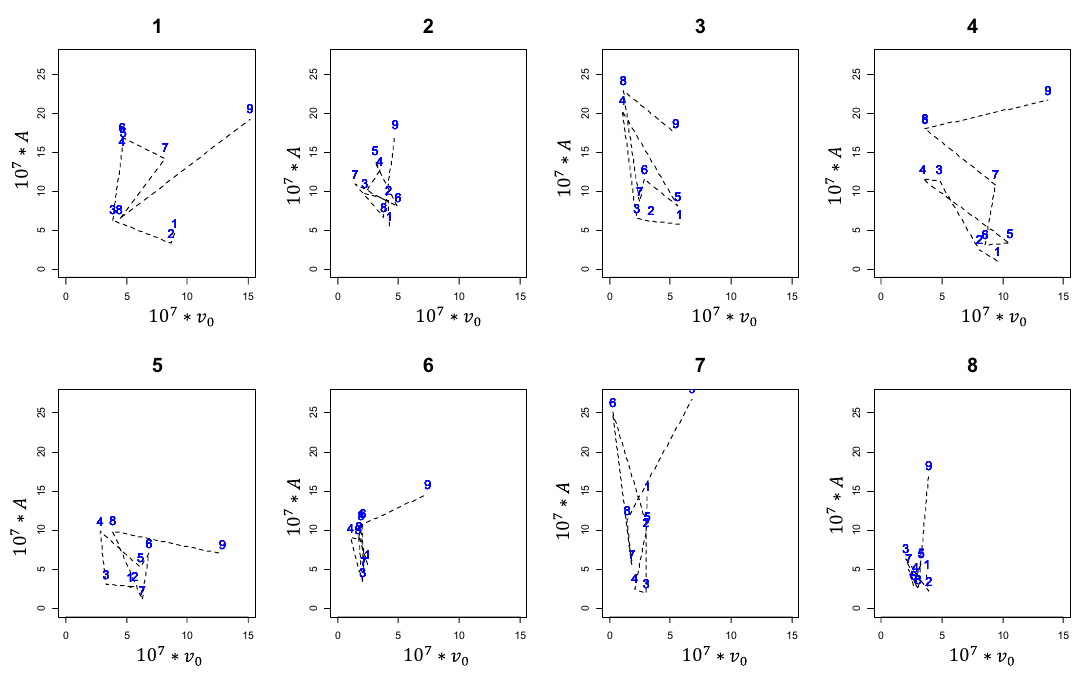
Figure 7. Phase trajectories of goats in response to the high-concentrate diet challenge. Each graph shows the trajectories of each individual goat in terms of A and v 0 , represented by dashed lines. Goat numbers from 1 to 8 are stated above each graph. Sampling days (from 1 to 9) are in blue inside each graph. Both variables v 0 and A are rescaled by 10 7